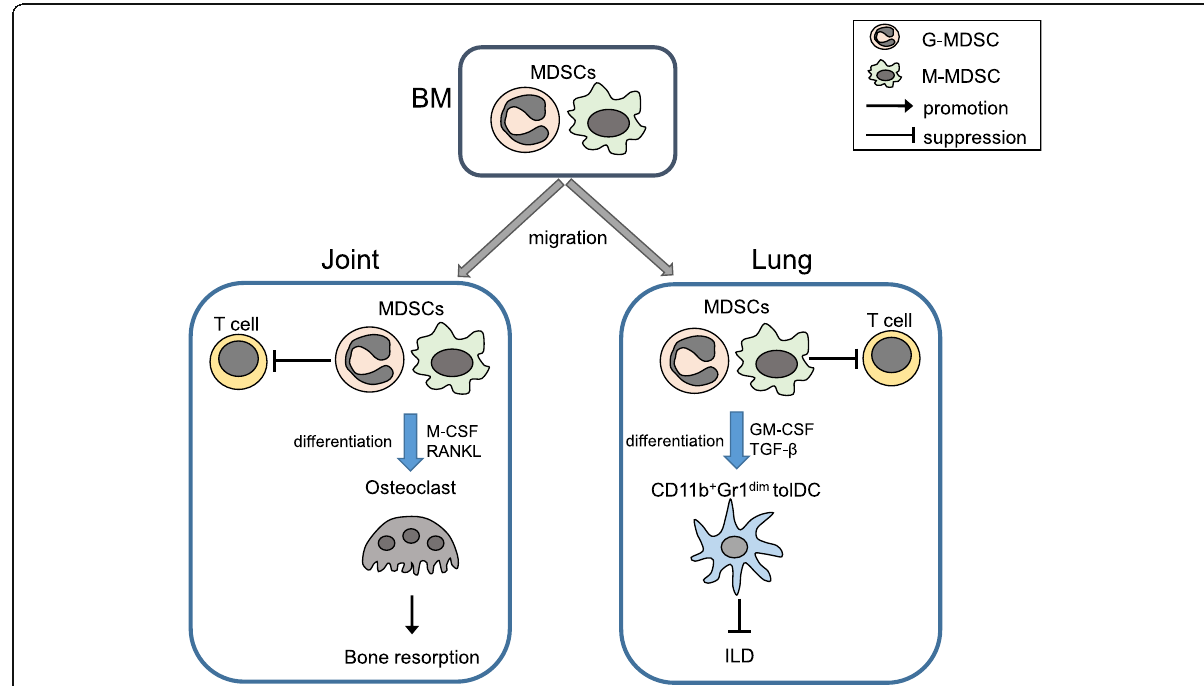
Fig. 1 The plasticity of MDSCs in non-neoplastic inflammatory conditions. MDSCs from the bone marrow of CIA mice can differentiate into osteoclasts capable of bone resorption in vitro and in vivo. In the lungs of SKG mice, M-MDSCs differentiate into CD11b + Gr1 dim tolerogenic DCs (CD11b + Gr1 dim tolDCs), which suppress the progression of